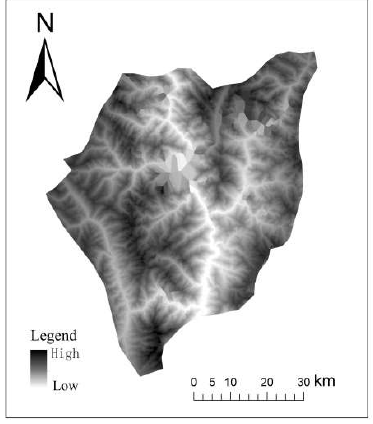
Figure 7. Digital elevation model (DEM) of the test area. Table 3. Calculation results for the surface area at different resolutions in the verification area. Resolution Ratio of DEM